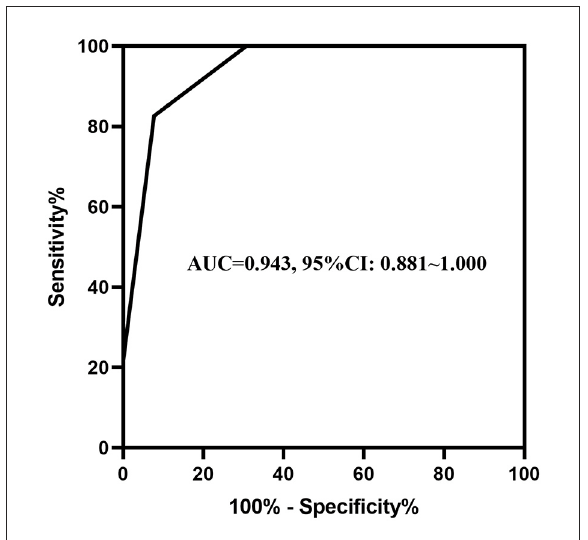
FIGURE4 The ROC curve of abdominal signs combined with the serum biomarkers. The AUC of abdominal wall tenseness and abdominal tenderness combined with Relm β concentration was 0.943 (95% CI: